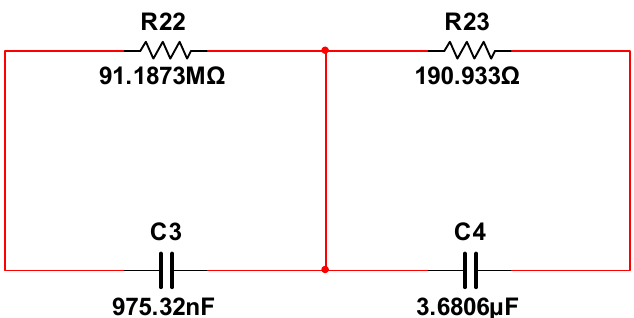
Figure 8. The fractional-order chain circuit unit.